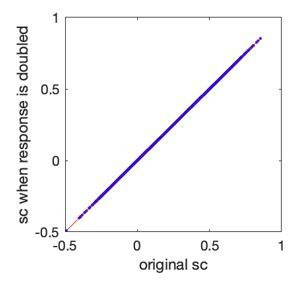
Pairwise signal correlations for all pairs of simultaneously recorded ferret neurons.The signal correlation (SC) was calculated as in our original manuscript (x-axis) or after doubling the response strength of one neuron in each pair (y-axis). This scaling of the response strength has no effect on the resulting signal correlation. Signal correlations of individual pairs of neurons are plotted as blue dots, and these all fall on the line of equality (red).